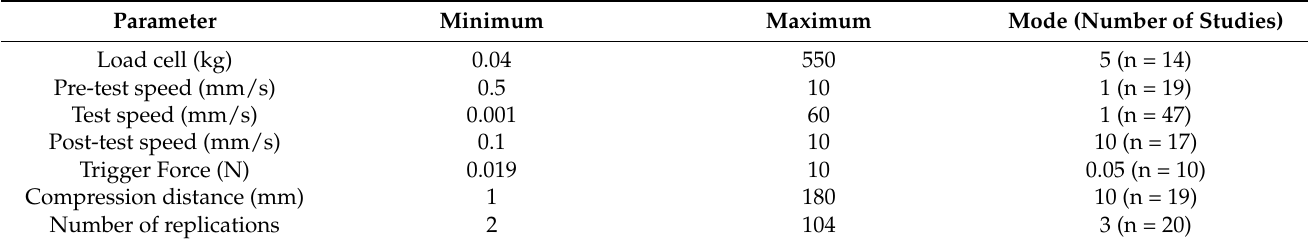
Table 4. Test parameters used in the experiments of instrumental texture